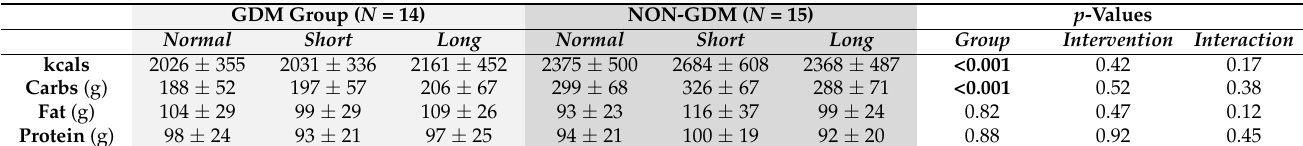
Table 4. Mean daily dietary intake in women with and without GDM throughout the NORMAL, SHORT, and LONG conditions.